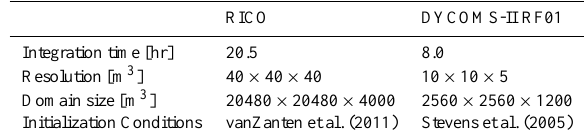
Table 1. Conditions for the LES